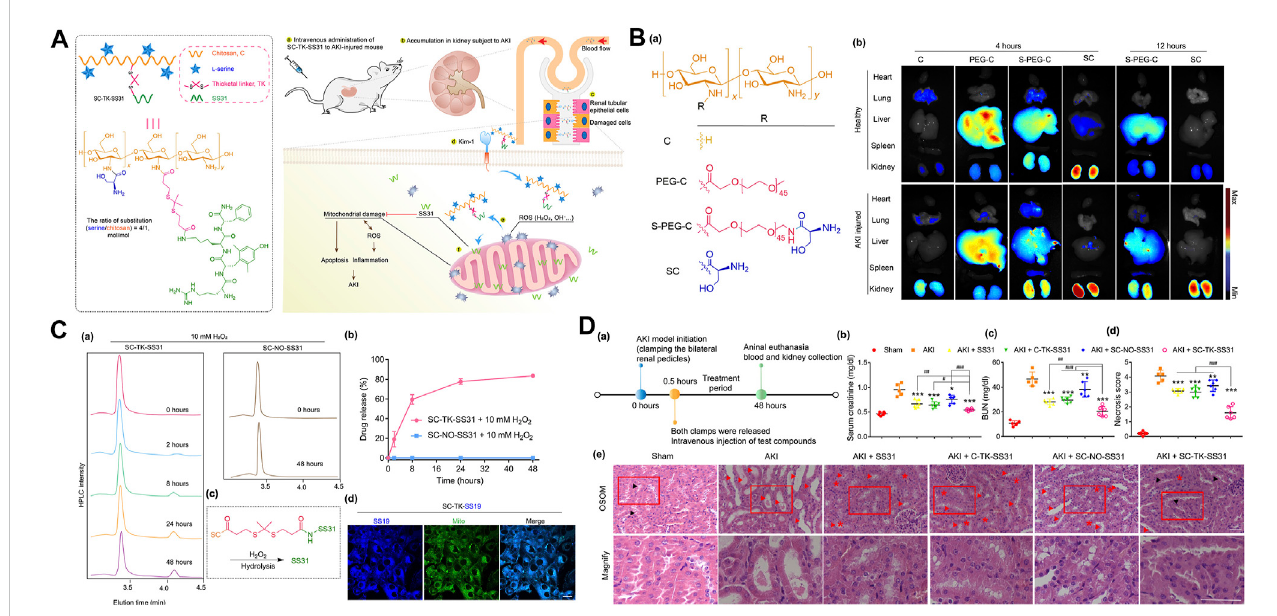
FIGURE 3 (A) Schematic illustration of the design and structural of ROS cleavable polysaccharide drug precursor SC-TK-SS31, and the principle for targeted AKI treatment; (B)(a) thedesignandstructuralofL-serine-modi fi edchitosan(SC)anditsanalogues, (b) Fluorescentimagesofheart, lung,liver, spleenandkidney ofmiceat4or12 hafterintravenousinjectionofvariousofCy5-labeled SCanditsanalogues; (C)(a) Theabsorption peak(220 nm)ofSC-TK-SS31monitored by HPLC in the presence of 10 mM H 2 O 2 , (b) the release curve of SC-TK-SS31 and SC-NO-SS31 dissolved in H 2 O 2 (detected by HPLC), (c) Schematic diagram of SS-31 synthesis (d) Confocal image of HK-2 cells induced by H 2 O 2 incubated with SC-TK-SS19 for 12 h. (D) (a) the schedule for the blood and kidney collection 48 h after intravenous injection of different drugs for AKI mice, (b) Determination of serum creatinine, (c) blood urea nitrogen (BUN) and (d) necrosis score in AKI mice after different treatments, (e) hematoxylin eosin (H&E) staining of renal tissue after different treatment. Adapted with permission from (Sci. Adv. 2020, 6 (41), eabb7422.) (Liu D. et al.,